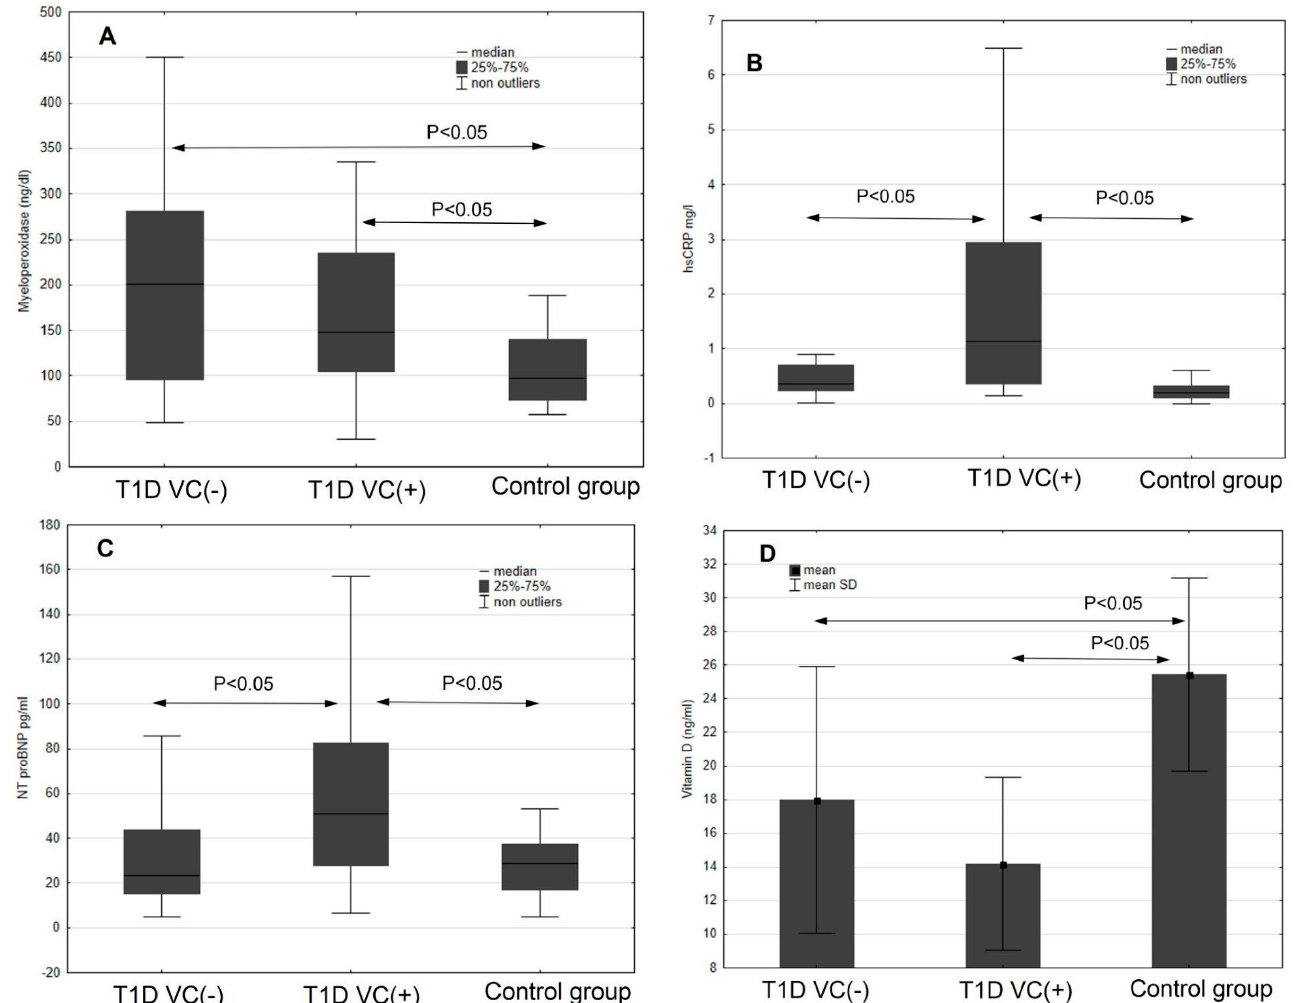
Figure 2. Selected “new biomarkers” ( A – D ) of the atherosclerotic process in the studied groups. At the end, we investigated the IMT value. We found that the intima-media of the carotid arteries were significantly thicker in both diabetic groups in comparison to the controls. The IMT value was the highest in the group with T1D and VC (+), and the dif- ferences between the VC ( − ) group and the controls were significant (Figure 3). IMT cor- related positively significantly with SDS-BMI, systolic blood pressure, HbA1c, hsCRP, NT-proBNP and inversely with vitamin D3 concentration (Figure 4). Table 3 shows other results of the correlations between intima-media thickness and the evaluated risk factors and the new biomarkers of CVD in T1D VC (+) patients. Multivariate regression analysis concerning these patients demonstrated that IMT was dependent on systolic blood pres- sure and glycated hemoglobin (R2 = 0.48, B = 0.18, p = 0.001). Table 3. Analysis of associations between IMT and studied variables in group of T1D with vascu- lar complications VC (+). IMT Age Rho = 0.1